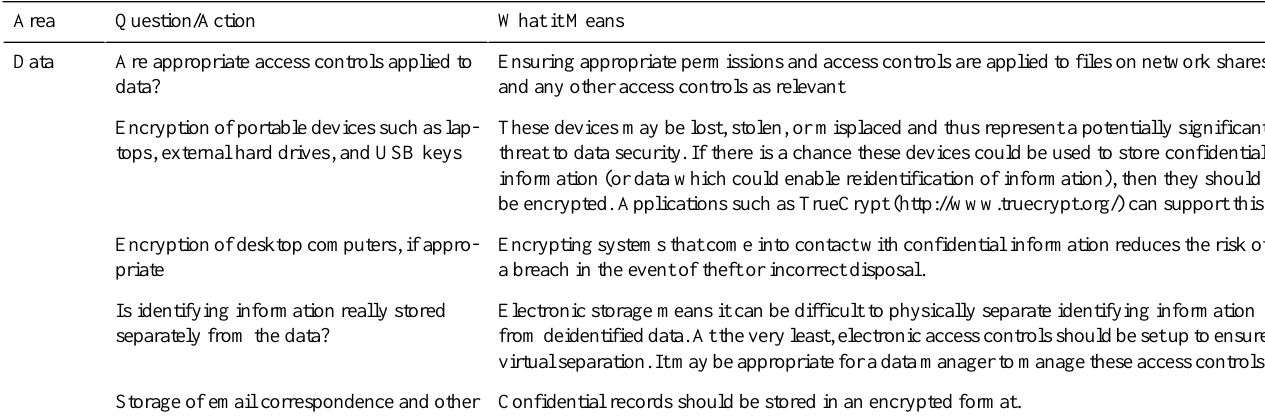
Table 2. Examples of questions and actions that are relevant to procedural security